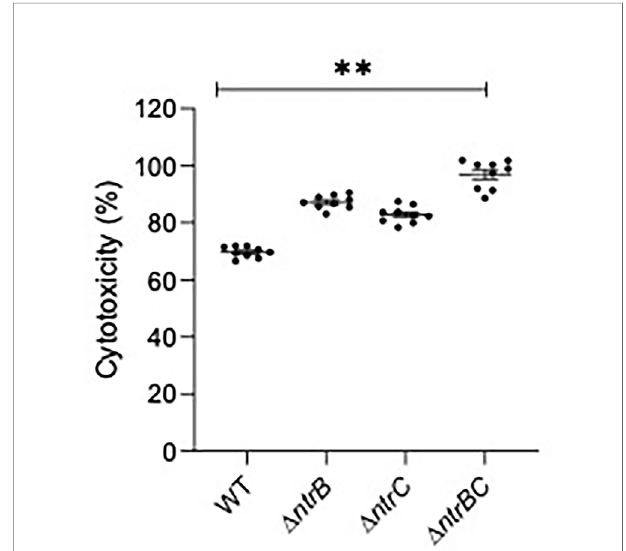
FIGURE 6 | Mutation of the nitrogen regulatory two-component system, NtrBC, increased host-directed cytotoxicity of P. aeruginosa . Con fl uent human bronchial epithelial (HBE) cells (~7.5 x 10 4 cells/well) were treated with mid-log phase bacteria at a multiplicity of infection (MOI) = 1 and incubated at 37°C for 16-18 h. Cell-free supernatants were collected and host-directed cytotoxicity (%) was estimated by LDH release from cells relative to cells lysed with Triton X-100. Signi fi cantly more cytotoxicity was caused after infection with P. aeruginosa D ntrBC mutants. Data are presented as mean ± standard error of the mean from four independent experiments containing three biological replicates each ( n = 12). ** P < 0.01 according to One-Way ANOVA followed by Dunn ’ s post-hoc